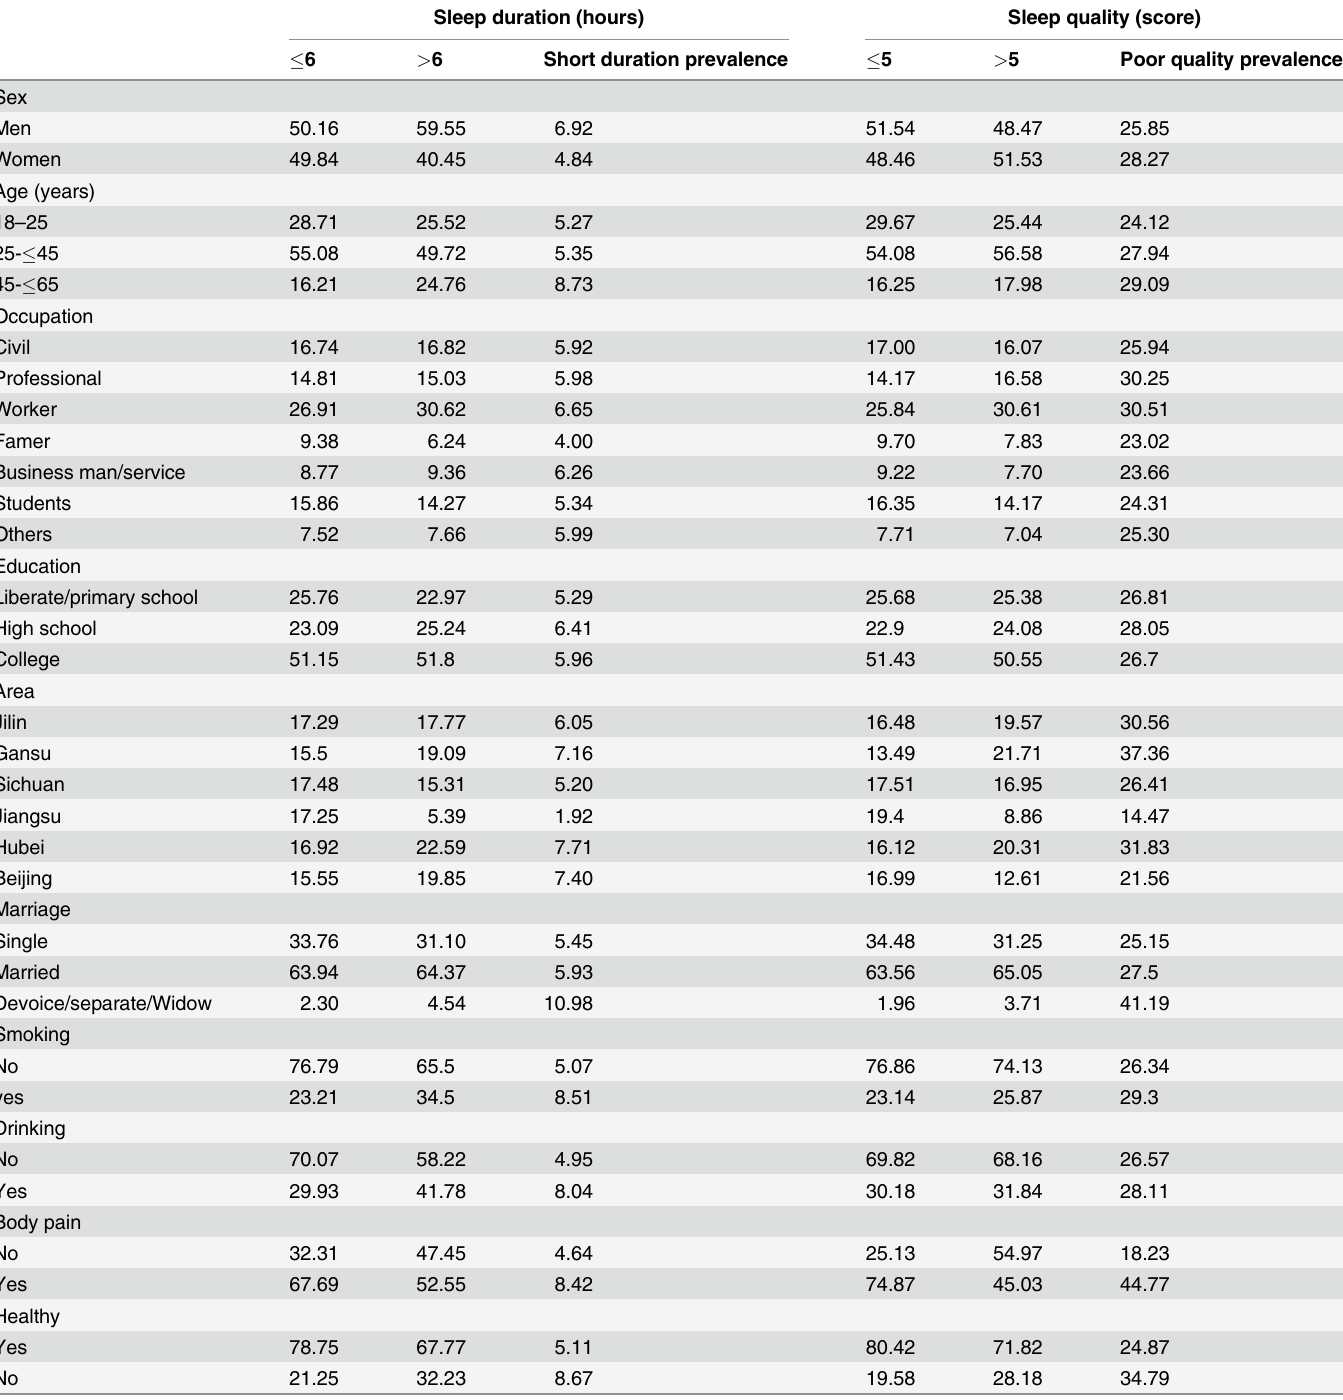
Table 1. Participant characteristics and frequencies (in %) within each sleep duration and quality category. Sleep duration (hours) Sleep quality (score) Short duration